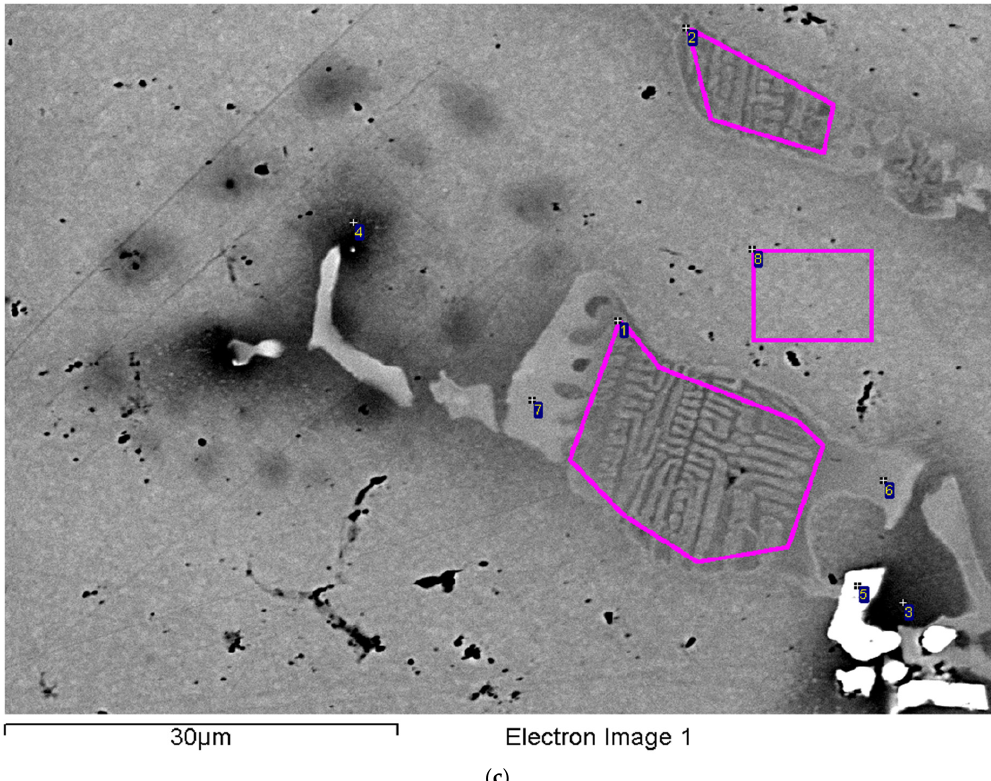
Figure 3. Details of lamellar microstructure and composition (at.%) of phases in the bulk of NV1-AC. ( a ) Analyses 1 to 6 as follows: 1: solid solution 42.8Nb-30.6Ti-1.7Si-5.9Al-4.1Cr-5.1Hf-2.9Sn-6.9V, 2: solid solution 38.1Nb-31.7Ti-2.2Si-5.7Al-